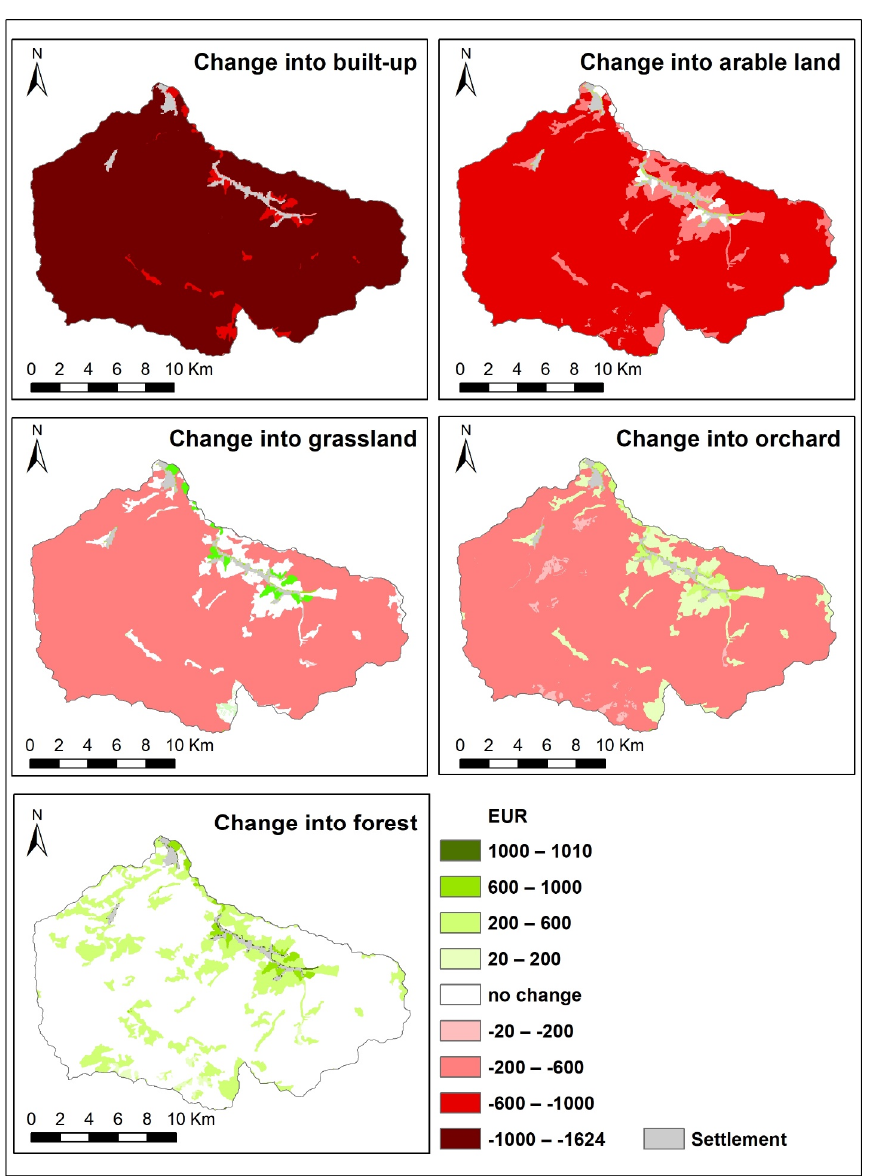
Figure 9. Estimated changes in cost of the flood protection ecosystem services (ES) in the case of land use change.